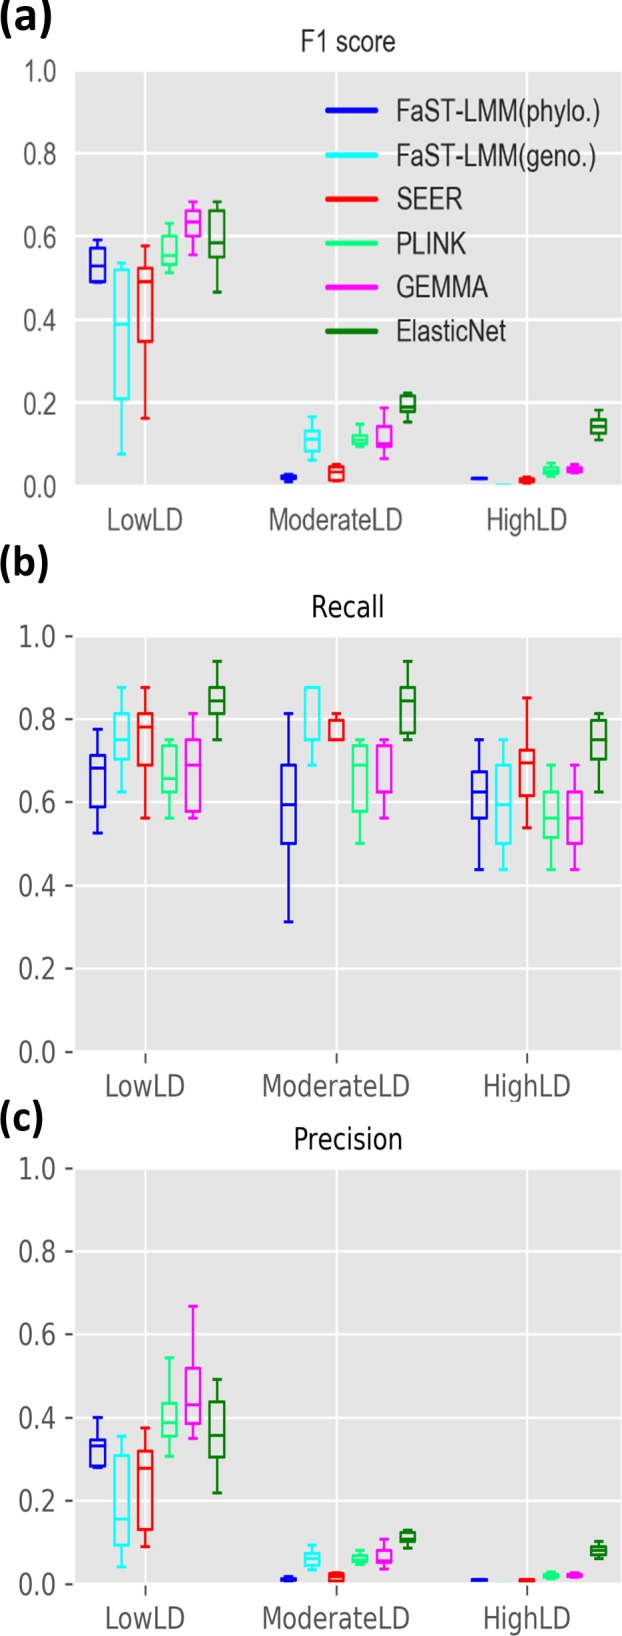
Effect of LD on GWAS performance. (a) F1 score, (b) recall and (c) precision of GWAS methods in datasets of 3000 genomes with low, moderate and high genome-wide LD levels. Boxplots show the median and interquartile range, averaged across a range of effect sizes over ten replicates in each scenario (log OR=1 to 3).